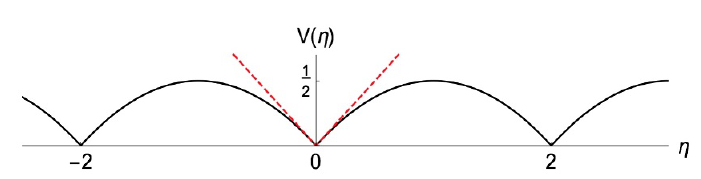
Figure 2. Periodic extension of the potential (2.13). For j (cid:17) j (cid:28) 1 the potential behaves as V ( (cid:17) ) (cid:25) j (cid:17) j